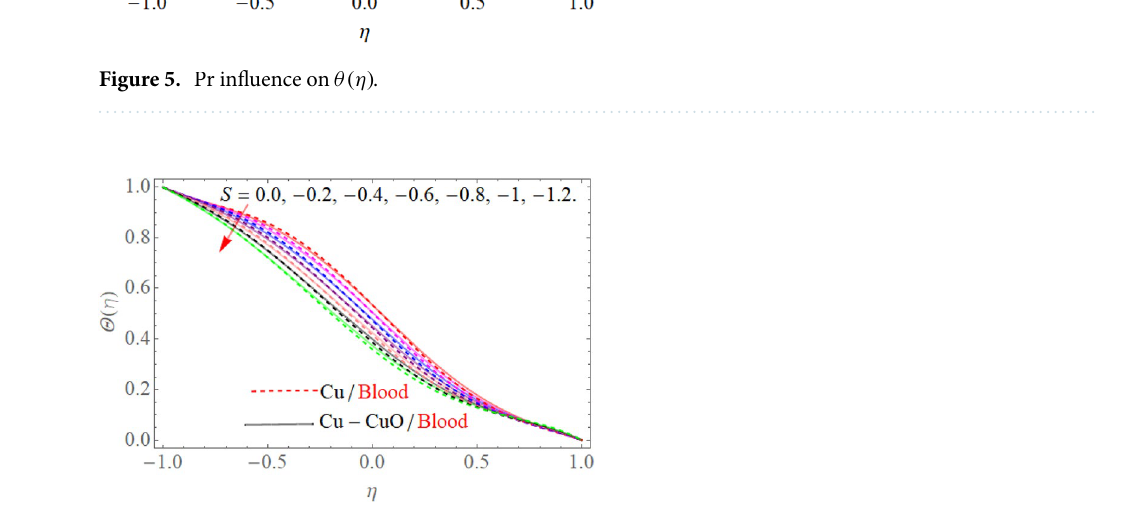
Figure 6. S influence on θ(η)